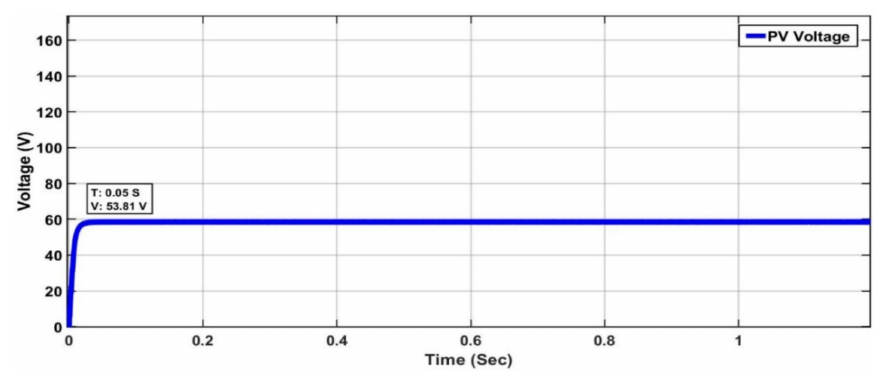
Figure 27. MPPT of Firefly Algorithm (Case-2).